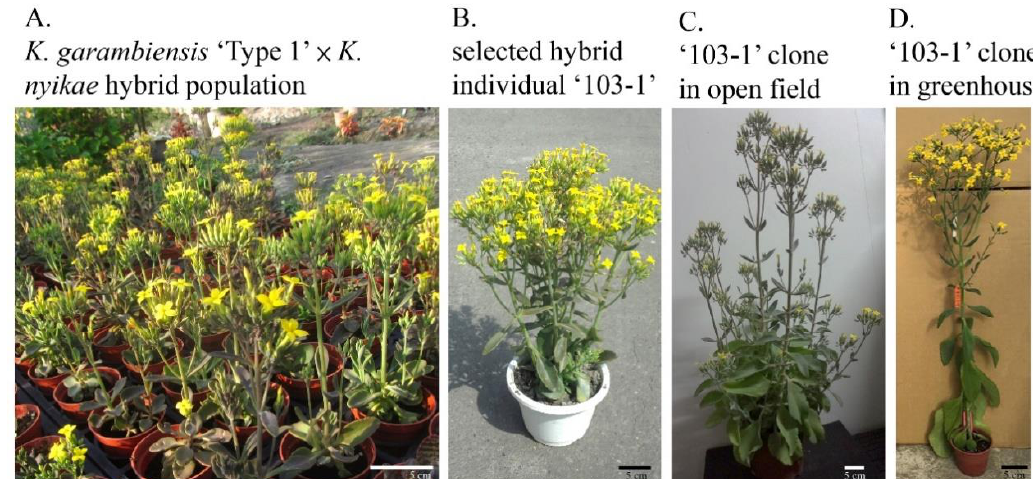
Figure 1. Appearance of hybrid ‘103-1’ derived from K. garambiensis ‘Type 1’ × K. nyikae . ( A ) Part of the hybrid population of K. garambiensis ‘Type 1’ × K. nyikae, ( B ) The ‘103-1’ hybrid individual selected from the hybrid population of K. garambiensis ‘Type 1’ × K. nyikae cultivated on an open field. ( C ) A clone of ‘103-1’ propagated from a shoot tip, and cultivated on an open field. ( D ) A clone of ‘103-1’ propagated from a shoot tip and cultivated in a shaded greenhouse.